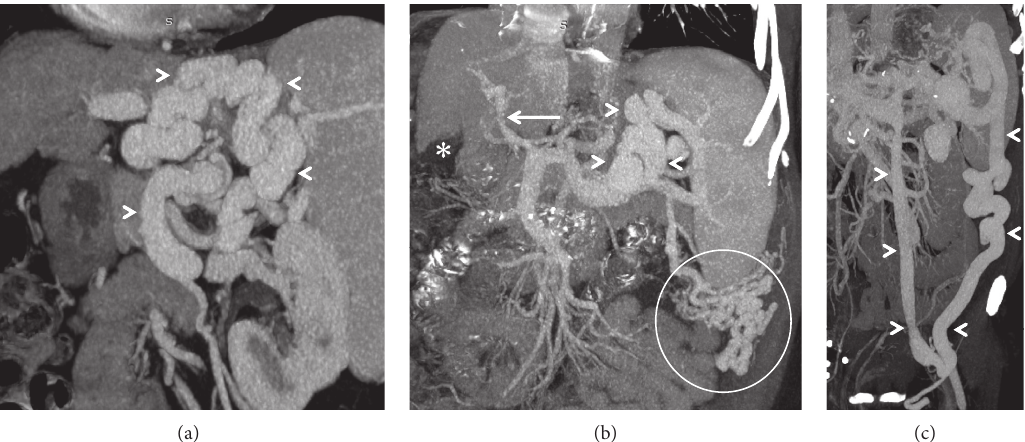
Figure 1: Coronal-oblique MIP images from three different patients depicting splenorenal shunts (arrowheads in (a, b)) and a sple- nogonadorenal shunt (arrowheads in (c)). Note. The presence of additional perisplenic portosystemic collateral vessels in (b) (encircled) with attenuated main portal vein (arrow) and ascites (asterisk).